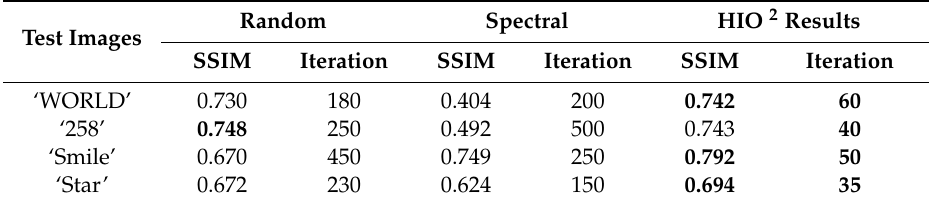
Figure 6. Four test images, including letters, numbers, and simple geometric figures. ( a ) WORLD. ( b ) 258. ( c ) Smile. ( d ) Star. Table 1. SSIM 1 and iterations of the proposed algorithm with di ff erent initialization